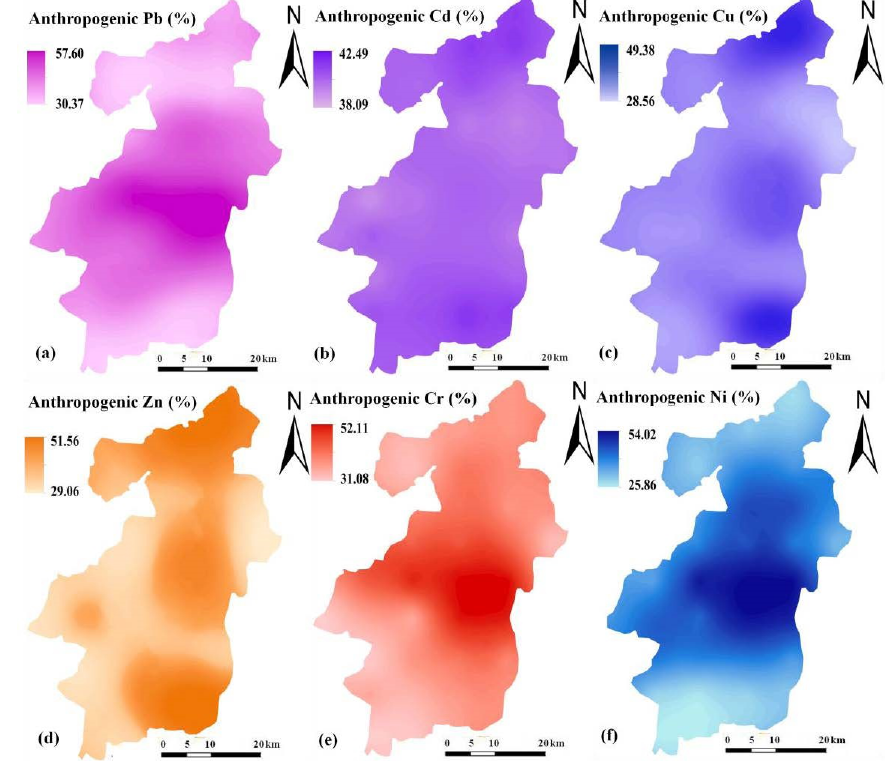
Figure 3. Spatial distribution patterns of anthropogenic Pb ( a ), Cd ( b ), Cu ( c ), Zn ( d ), Cr ( e ), and Ni ( f ) contributions in the topsoil.